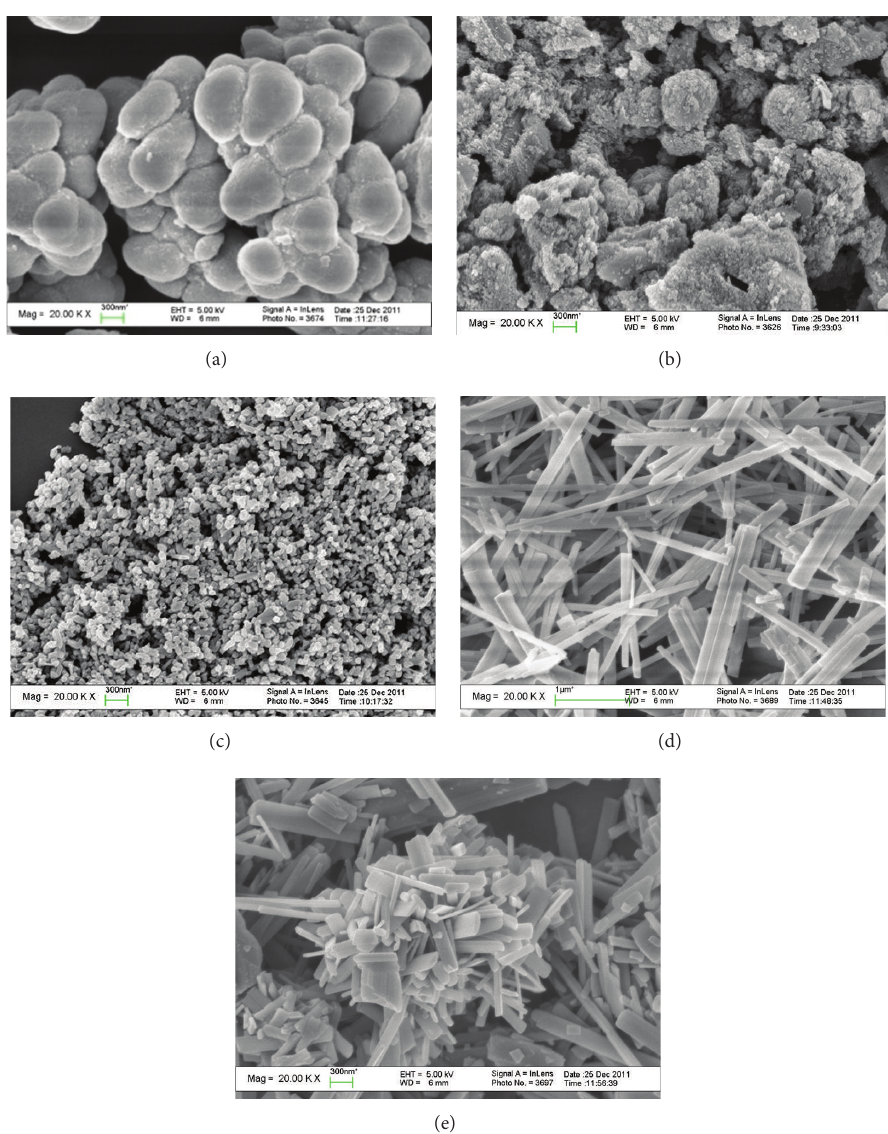
Figure 2: SEM image of Na 2 Ti 6 O 13 /TiO 2 composite particles. (a) 1.5-Na 2 Ti 6 O 13 /TiO 2 precursor; (b) 1.5-Na 2 Ti 6 O 13 /TiO 2 calcined at 500 ∘ C; (c) 1.5-Na 2 Ti 6 O 13 /TiO 2 calcined at 600 ∘ C; (d) 1.5-Na 2 Ti 6 O 13 /TiO 2 calcined at 700 ∘ C; (e) 1.5-Na 2 Ti 6 O 13 /TiO 2 calcined at 800 ∘